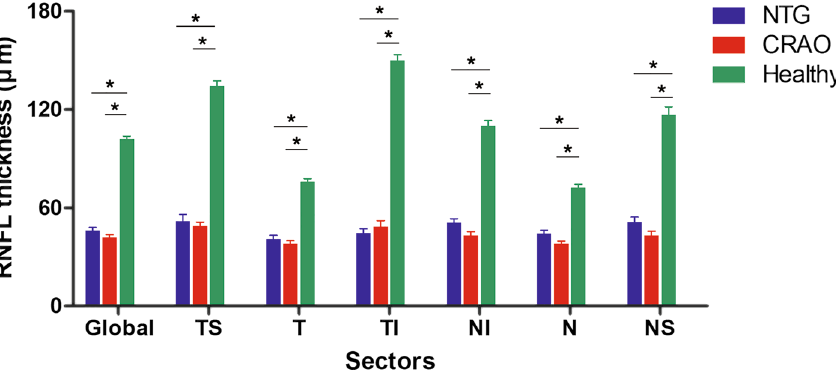
Figure 1. Distribution of circumpapillary retinal nerve fiber layer (RNFL) thicknesses in NTG, CRAO and healthy contralateral eyes. The horizontal bars represent the mean ± standard error of the mean. Asterisks indicate statistically significant differences ( P < 0.05). RNFL thickness did not differ significantly in any sector of eyes with normal tension glaucoma (NTG) and central retinal artery occlusion (CRAO). Healthy, contralateral eyes of subjects with CRAO; TS temporal–superior sector, T temporal sector, TI temporal–inferior sector, NI nasal–inferior sector, N nasal sector, NS nasal–superior sector.